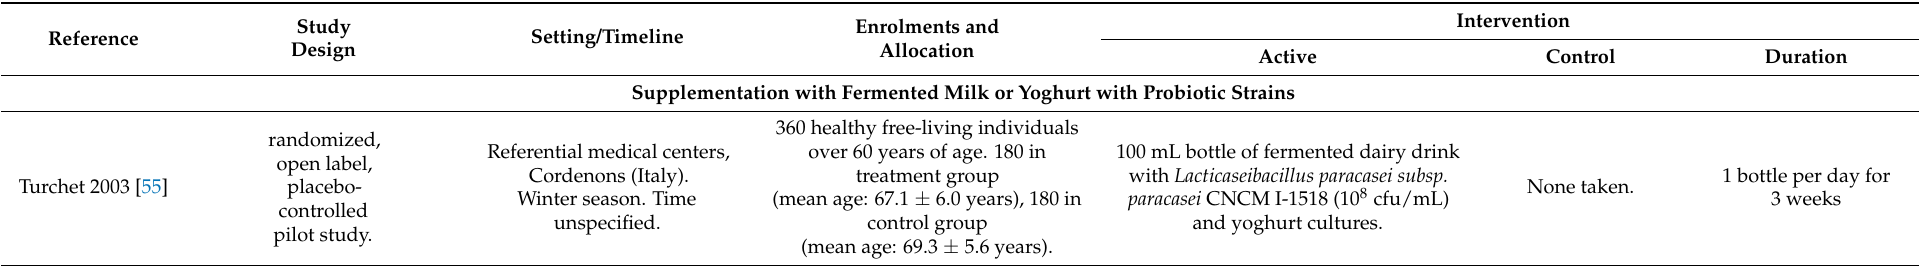
Table 4. Description of eight clinical studies on the effects of fermented drinks with probiotics and probiotic food supplements against acute upper respiratory tract infections in older